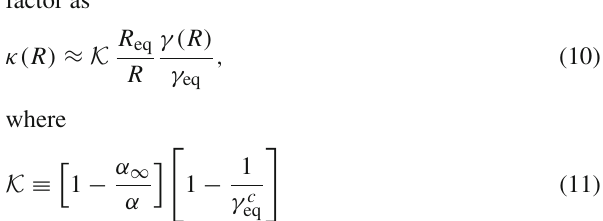
Fig. 1 The Lorentz factor of the bubble wall (left panel) and the effi- ciency factor κ (right panel) as a function of the bubble radius R for γ = 10 , 100 , 10 3 , 10 4 from light to dark. The solid black curves eq show the case (cid:3) P 1 → N ∝ γ and the orange dashed curves the case